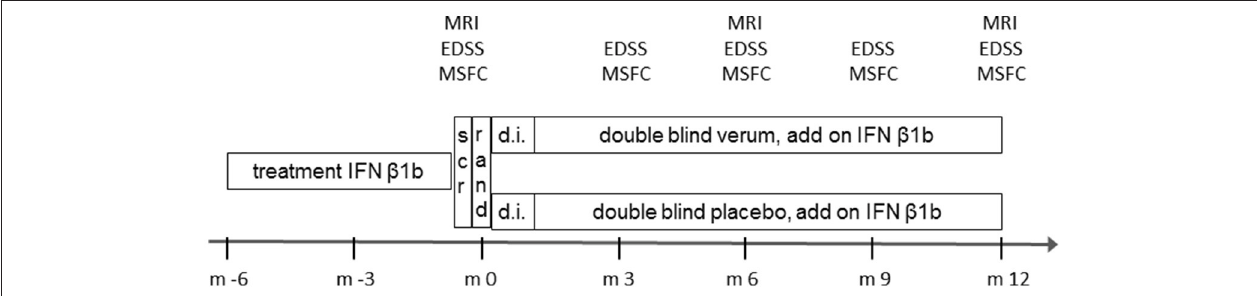
FIGURE 1 | Design of the FLORIMS study. scr, screening; EDSS, expanded disability status scale; IFN, interferon; m, month; MRI, magnetic resonance imaging; MSFC, multiple sclerosis functional composite; rand,